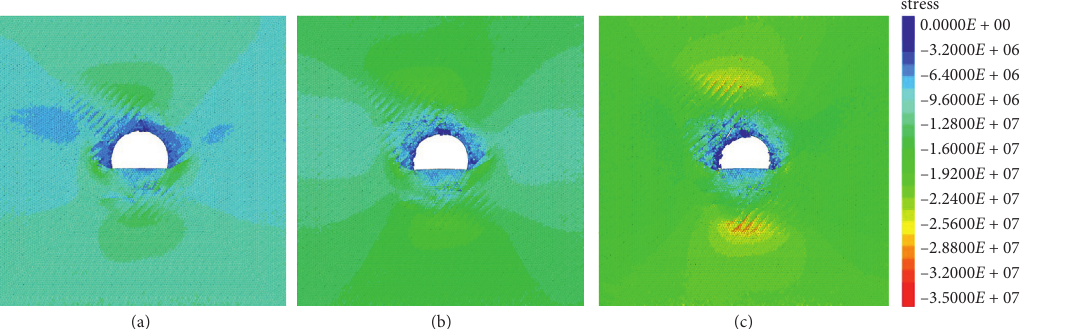
Figure 13: Distribution of maximum principal stress under different burial depths: (a) H � 250m, (b) H � 350m, and (c) H � 500